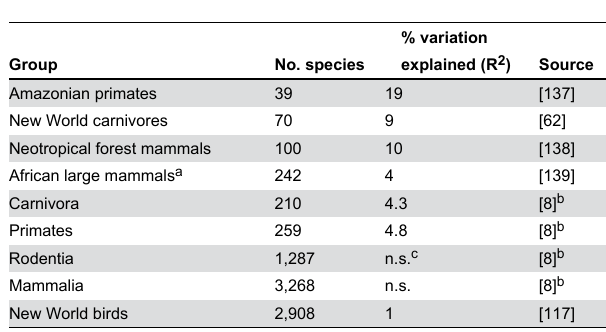
Table 1. Amount of variation in log explained as a linear function of log groups of mammals and New World